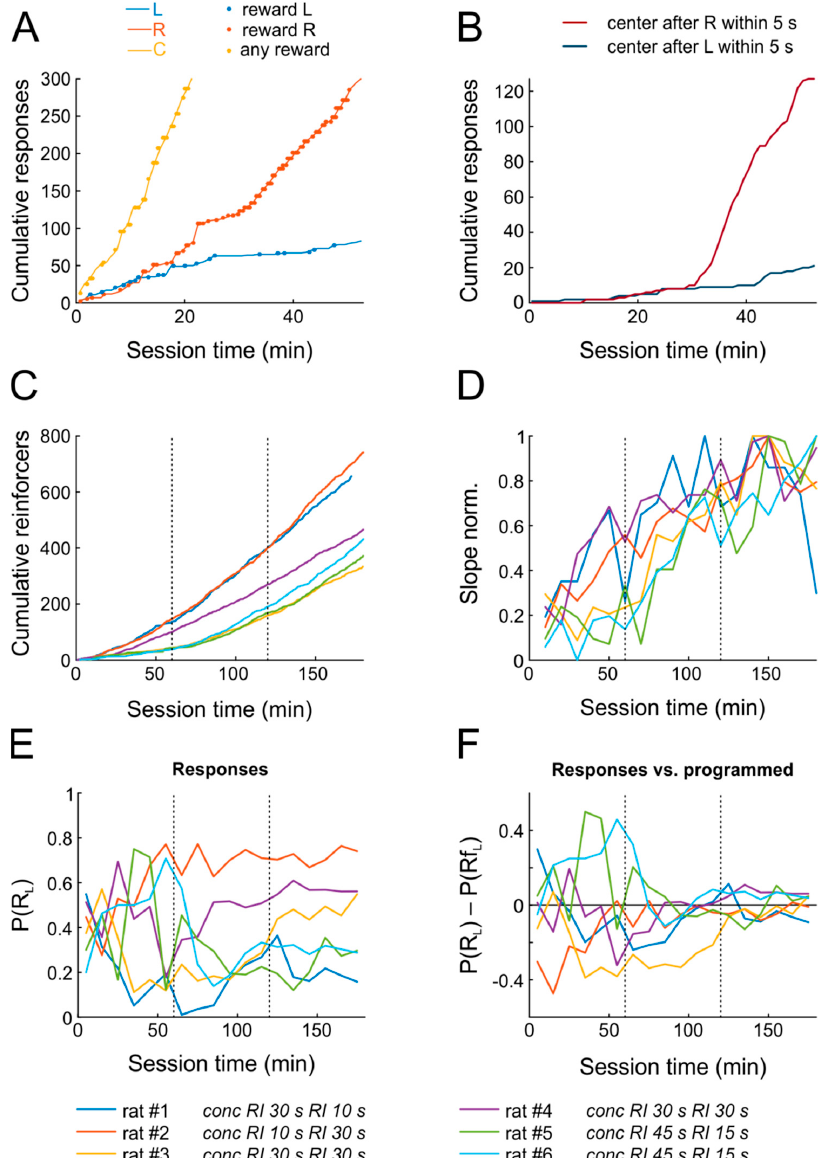
Figure 2. Rats pick up the basic task structure in the very first training session. ( A ) Cumulative numbers of operant responses in 1-min bins (time intervals) for pokes into the left (blue), right (red), and center (reward, yellow) port for one example animal on the first day of training. ( B ) Cumulative responses into the center port within 2 s after left (blue) or right pokes (red) for the same animal. ( C ) Cumulative numbers of reinforcers (in bins of 10 min) for all six rats across the first three sessions (separated by vertical dotted lines). The color code key for panels CDEF is given at the bottom of the figure. ( D ) The number of reinforcers obtained per 10-min bin over the first three days, normalized to the maximum number of reinforcers obtained in any bin by a given rat. For five out of six rats, the maximum number was obtained well before the end of the third session. ( E ) Relative response proportions P(R L ) for the six rats over the first three days. ( F ) As in E, but after subtraction of programmed relative reinforcement proportions P(Rf L ) from P(R L ) to highlight that all animals attained matching (horizontal line, zero di ff erence) by the third day of